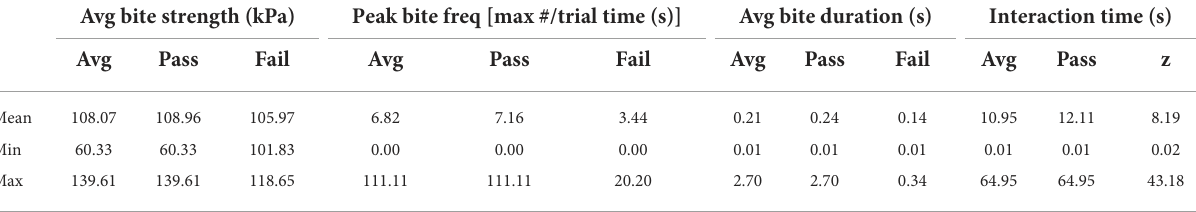
TABLE 3 Mean, min, and max values for each independent feature for the ball-ramp condition (feature average and by outcome; does not include trials with zero interactions).